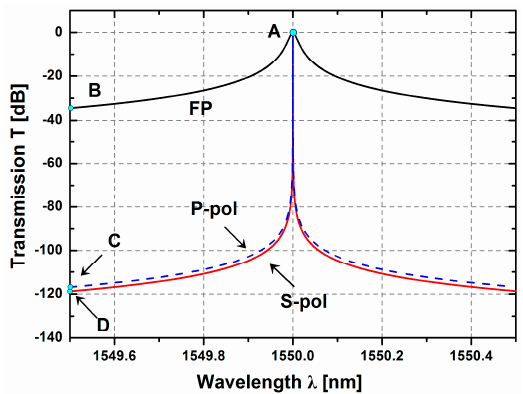
Figure 4. Transmission curves of both S- and P-polarizations with respect to displacement Δ H . For comparison, the transmission of the FP etalon ( R = 0.999, cavity length 12.94 λ ) is also plotted as a reference.